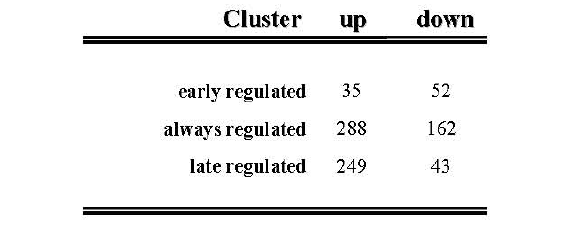
Numbers of Genes in Each Temporal Expression Pattern Cluster